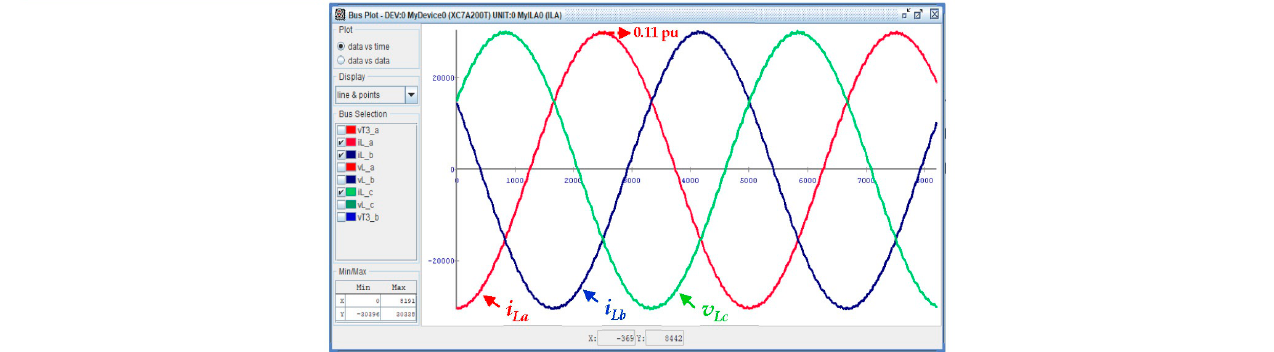
Figure 14. RT results—waveforms of the load voltages and currents obtained with three-phase voltage references set to 0.9 pu amplitude and 200 Hz frequency.